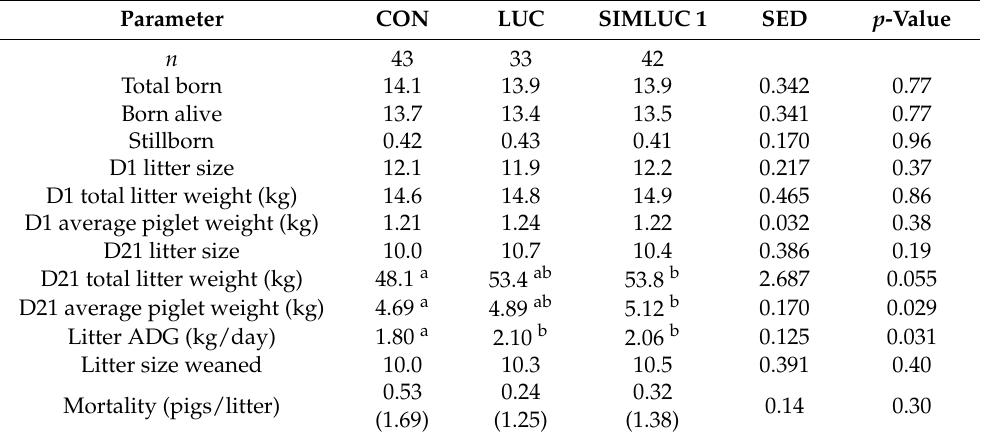
Table 3. Litter performance of primiparous sows fed a control diet (CON), lucerne (LUC), or a diet formulated to have similar DE, BCAA and tryptophan concentration as lucerne (SIMLUC